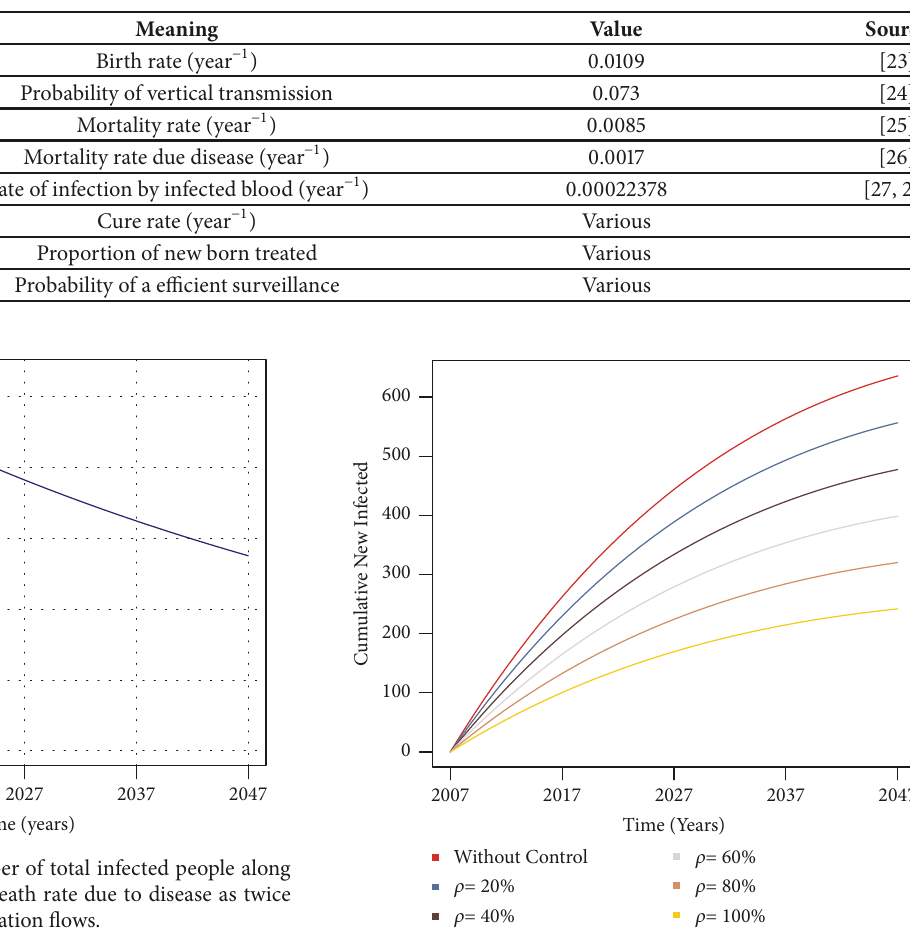
Table 1: Parameters used in numerical simulation of proposed model (1)-(8).